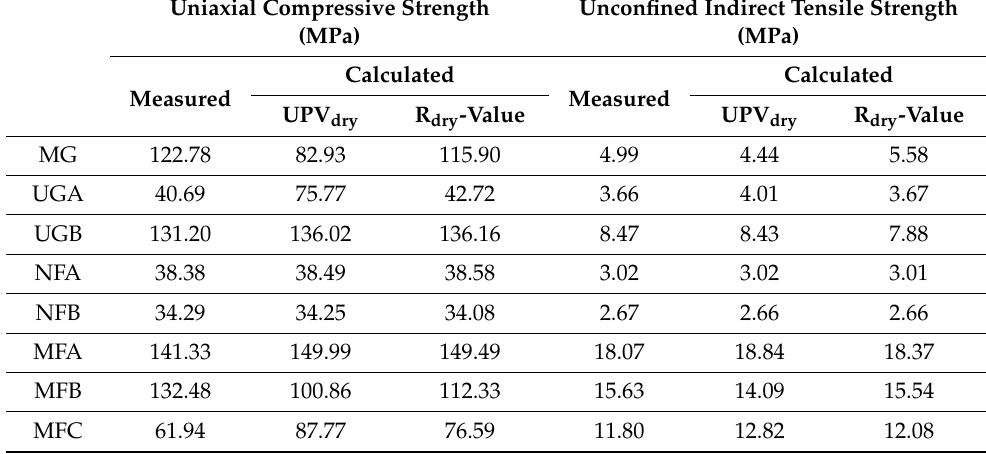
Table 10. Results of the t -test for the correlation of NDTs- dry against the strength properties of the studied rocks.